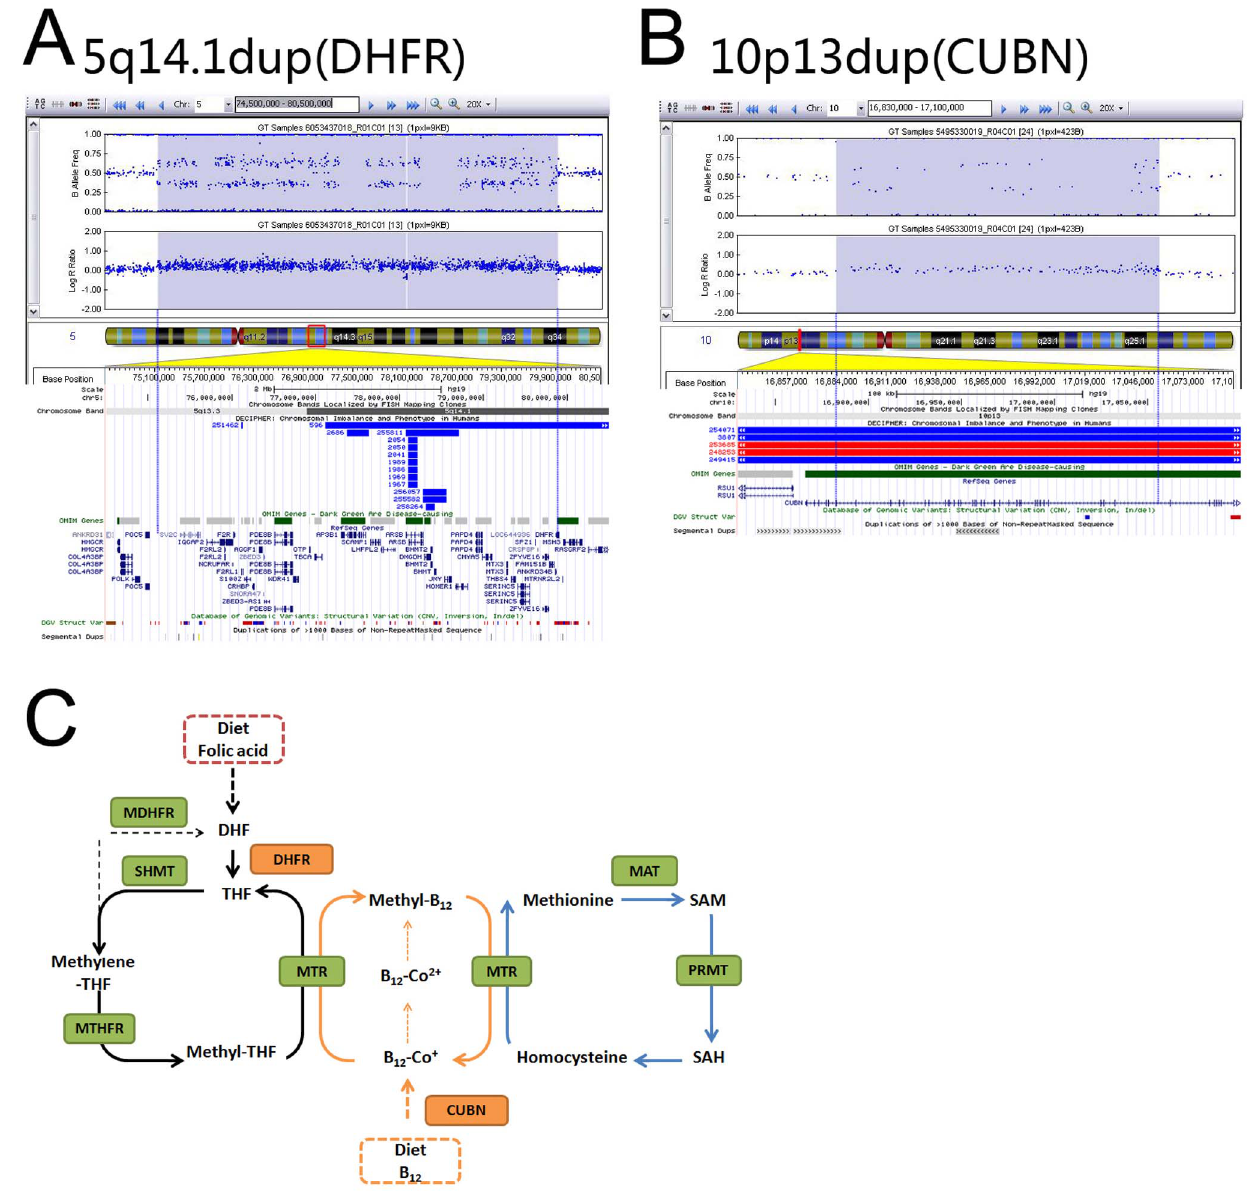
Figure 1. Rare CNVs related to folate and Vitamin B 12 metabolism. (A) SNP-array shows a 4.8 Mb duplication at 5q14.1 (chr5:75132315- 79958945); (B) A 175-kb duplication at 10p13 (chr10:16883466-17058324) (UCSC Genome Browser on Human GRCh37/hg19 Assembly). Log R ratio and B alle frequency are showed in the upper panel and annotated genes are listed in the lower panel. (C) Summary of Folate metabolic pathway (Methionine-Homocysteine-Folate-B12 Cycle). DHF, dihydrofolate; THF, tetrahydrofolate; DHFR, dihydrofolate reductase; MTHFR, methylenetetrahy- drofolate reductase; SHMT, serine hydroxyl-methyltransferase; MAT, methionine adenosyltransferase; SAH, S-adenosylhomocysteine; SAM, S- adenosylmethionine; MTR, methionine synthase; PRMT, protein arginine methyltransferase; CUBN, Cubilin. Adapted from Lee et al